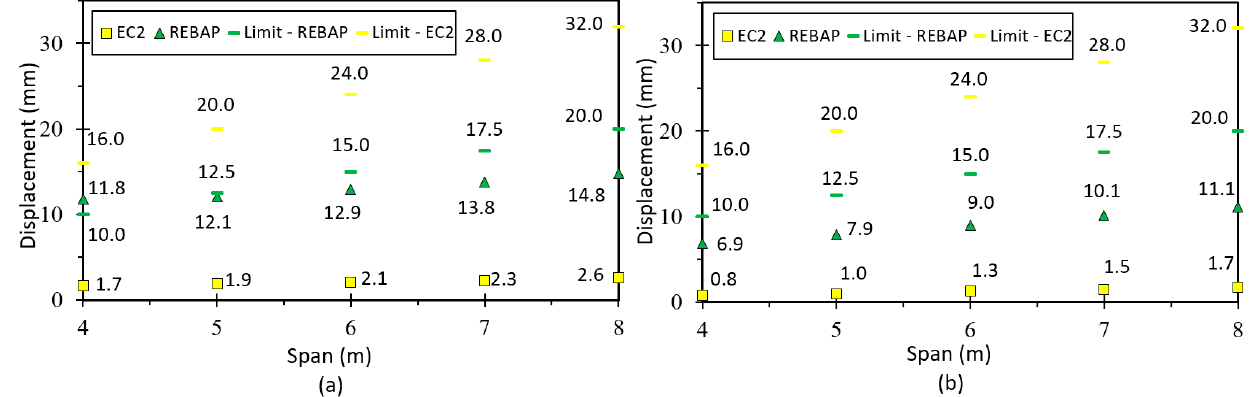
Figure 19. Deformation values of 2NLM: ( a ) analytical and ( b ) numerical, with their limit values, for simply supported slab.